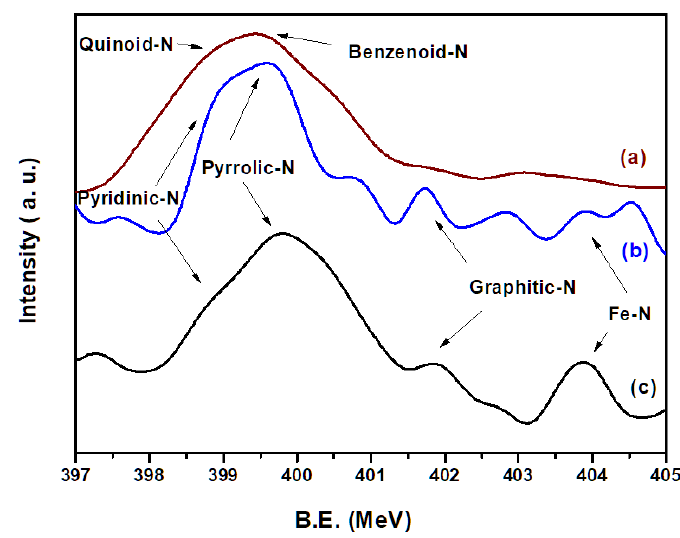
Figure 8. XPS spectra of N 1s of ( a ) PANI(EB) ( b ) FeNC ( c ) FeNC(OA).